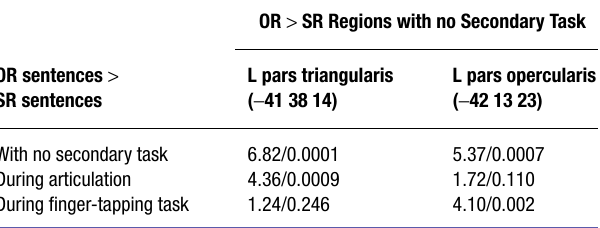
( Figure 5C , Table 3 ). This cluster’s location and extent is almost identical to the left pars opercularis region found in the object- relative vs subject-relative contrast during no secondary task. The left pars triangularis region that demonstrated an object-relative